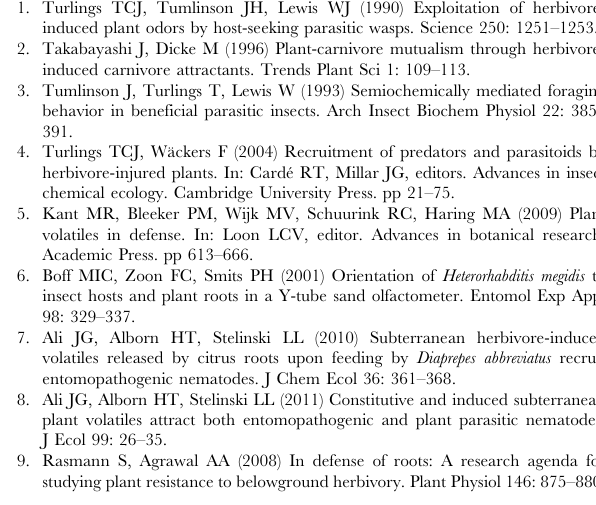
Figure S1 Conversion of pregeijerene (A) to geijerene (B). Figure S2 Chromatograms showing the initial crude extract prior to purification and final purified pregeijerene. The Y-axis represents relative abundance or the ratio of a mass peak profile area to that of another. These were calculated as ratios of the sums of areas used to plot the profiles 6 100%. Figure S3 Soil probe design used to sample volatiles below- ground. Probe is inserted into soil and connected to a vacuum pump. Figure S4 Chromatograms of volatiles taken from intact citrus roots in the field at one and 10 m distances from the trunk of the tree. The Y-axis represents relative abundance or the ratio of a mass peak profile area to that of another. These were calculated as ratios of the sums of areas used to plot the profiles 6 100%.